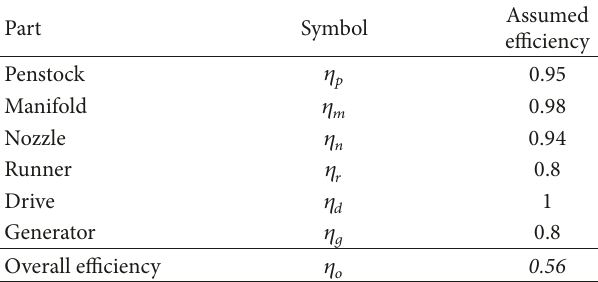
Table 4: Pelton turbine parts’ assumed efficiency [6].